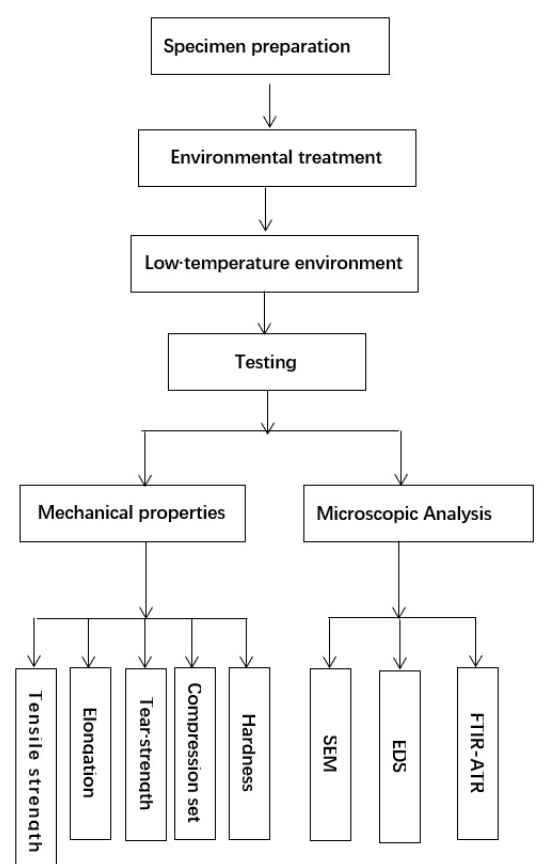
Figure 1. Experiment flow chart.